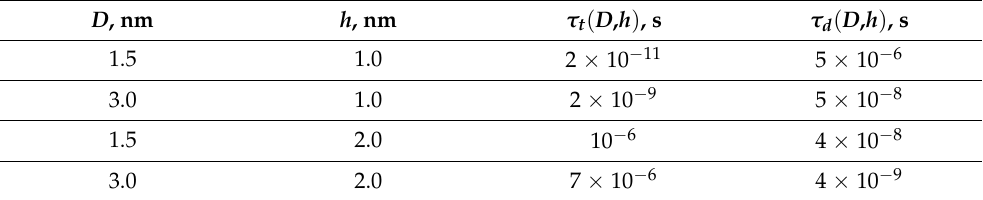
Table 1. Tunnelling times τ t for electrons from the home NW into the hole NW (see Appendix A) and  for electrons from the home NW into the hole NW (see Appendix A) exciton dissociation times τ d estimated using Equation (2) for T = 77 t and exciton dissociation times τ d estimated using Equation (2) for T = 77 K.